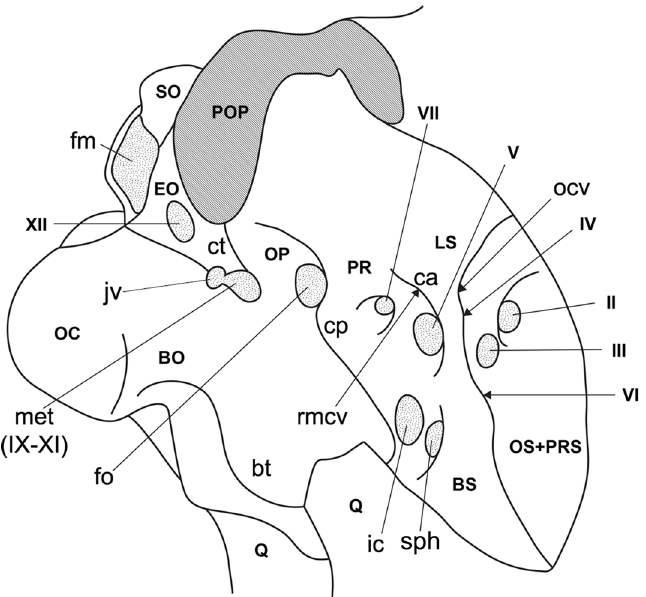
Fig 4. Simplified line drawing of the right lateral side of the braincase of Pawpawsaurus (FWMSH93B.00026) showing the re-interpretation of the cranial nerves. Abbreviations: bo, basioccipital; bt, basal tuber; eo, exoccipital; fm, foramen magnum; fo, fenestra ovalis; ic, internal carotid artery; jv, jugular vein; ls, laterosphenoid; met, metotic foramen (for CN IX – XI); oc, occipital condyle; ocv, orbitocerebral vein; op, opisthotic; pop, paroccipital process; pro, prootic; q, quadrate; rmcv, rostral middle cerebral vein; so, supraoccipital; sph, sphenoid artery; II – XII, cranial nerves.